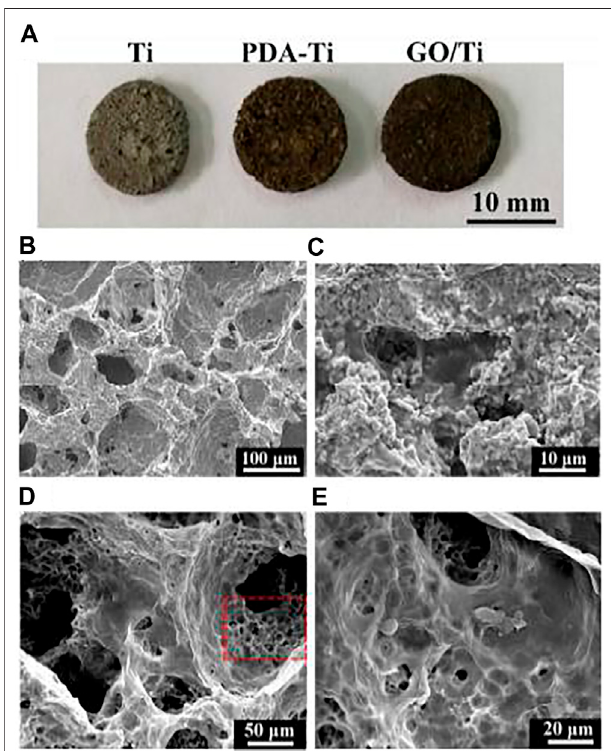
FIGURE 6 | (A) Photo of the pure Ti, PDA modi fi ed Ti (PDA-Ti), and GO- wrappedTiscaffolds. (B) SEMmicrographsshowingmicroporesintheTiscaffold. (C) PDA ad-layer was coated on the surface of the Ti scaffold. (D) GO uniformly coveredonthePDA-Tiscaffold. (E) Magni fi edimageof (D) ,showingwrinkled GO nanosheets wrapped in the pores of the Ti scaffold. Reproduced from Han et al. (2018b) with permission from Copyright 2018 Royal Society of